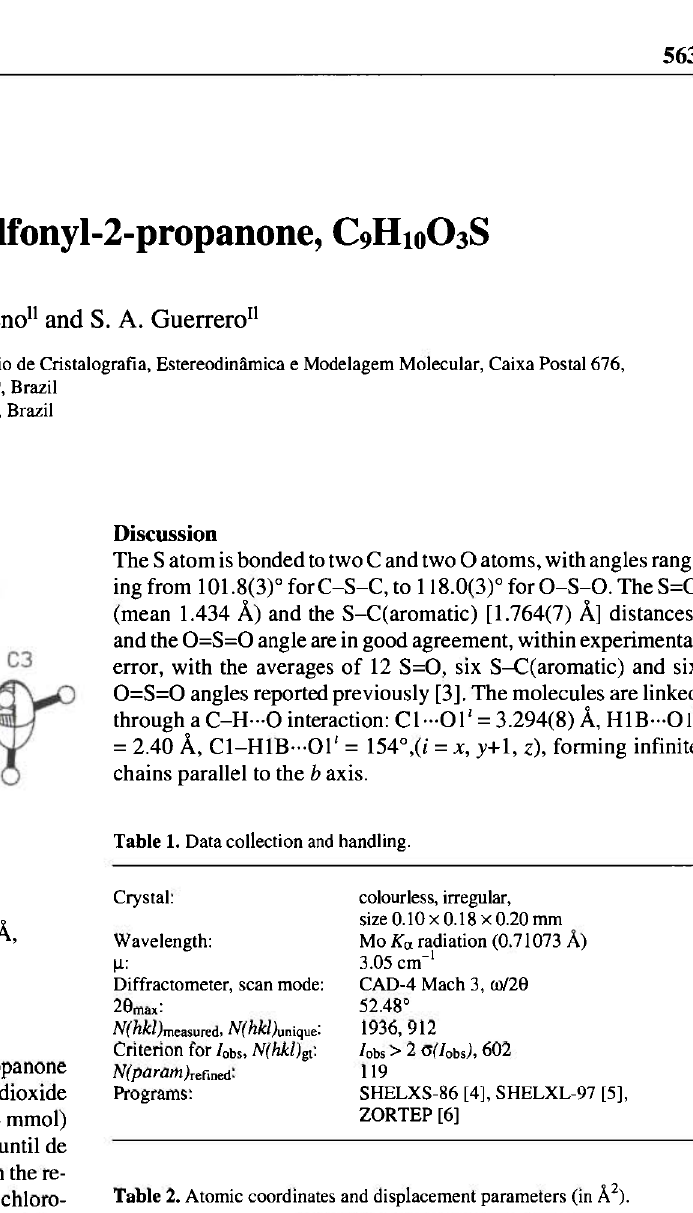
Table 3. Atomic coordinates and displacement parameters (in Ä 2 ).